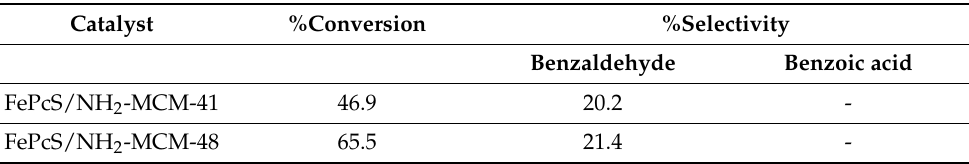
Table 4. Oxidation of styrene using iron phthalocyanine immobilized on MCM-41 and MCM-48 mesoporous support [72].